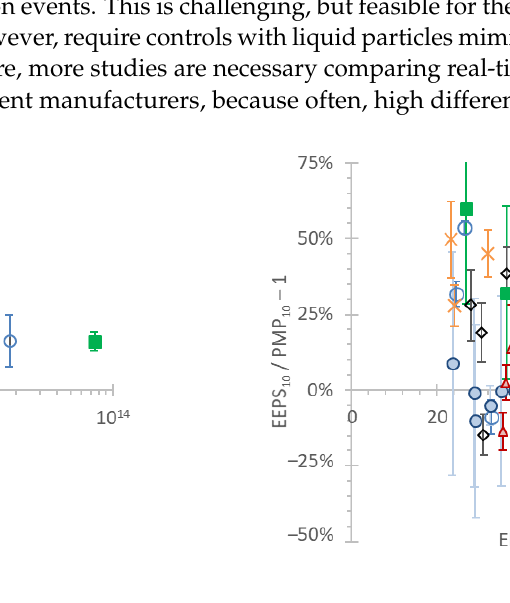
( b ) Figure 8. Overview of literature studies. ( a ) PN concentration ratio (EEPS to reference) in function of the reference instrument (CPC or SMPS) concentration; ( b ) Correlation between EEPS and SMPS: ( a ) geometric mean diameter (GMD). All studies used the “Default” EEPS matrix, except those with a black frame that used the “Soot” EEPS matrix. Data f rom: silver [83], salt [15,44,45,84,85], vehicle